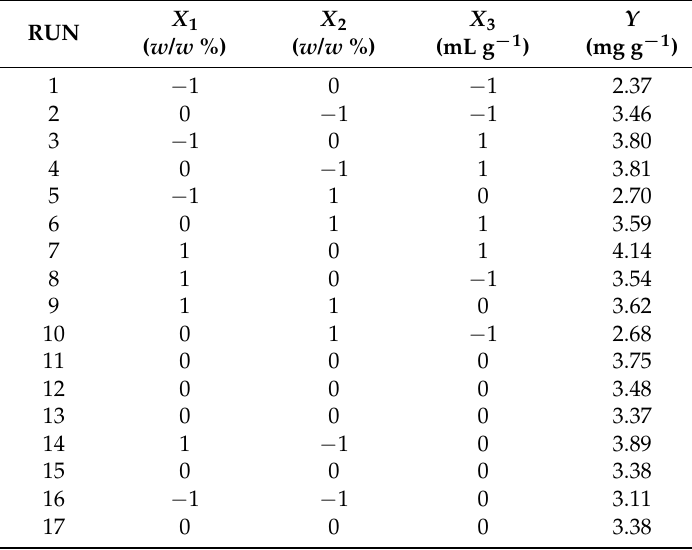
Table 2. Experimental design and results for response surface analysis.